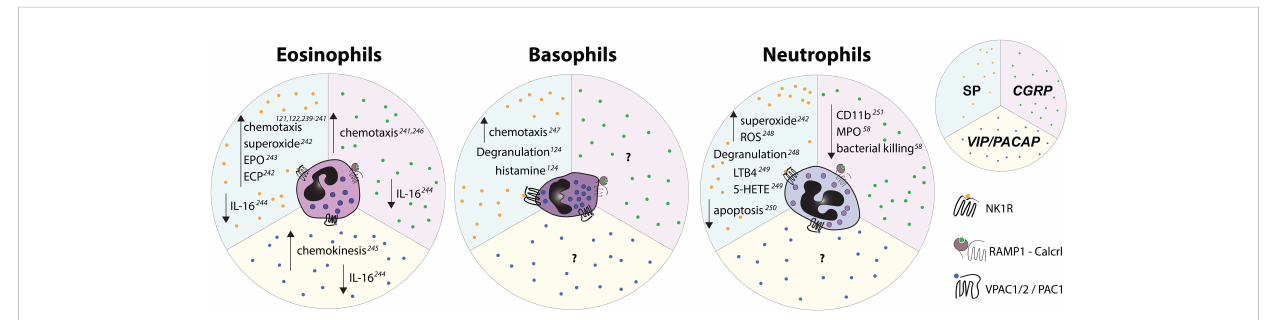
FIGURE 6 Effects of select nociceptive neuropeptides on polymorphonuclear granulocytes observed in vitro . Upward pointing arrows signify upregulation/ activation, downward facing arrows signify